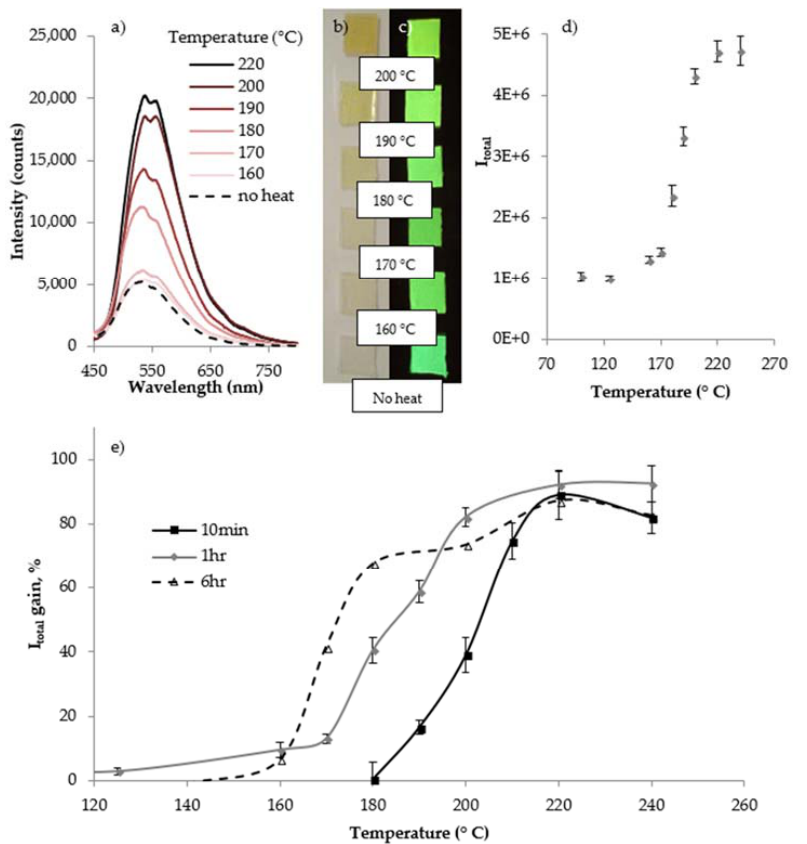
Figure 7. Fluorescent response of sensors to 1 h thermal exposures at various temperatures. ( a ) Emission spectra; ( b ) Ambient light images showing color change; ( c ) Fluorescent images showing intensity increase; ( d ) Integrated intensity values for 1 h exposure; ( e ) I total gain % for 10 min, 1 h and 6 h exposures.